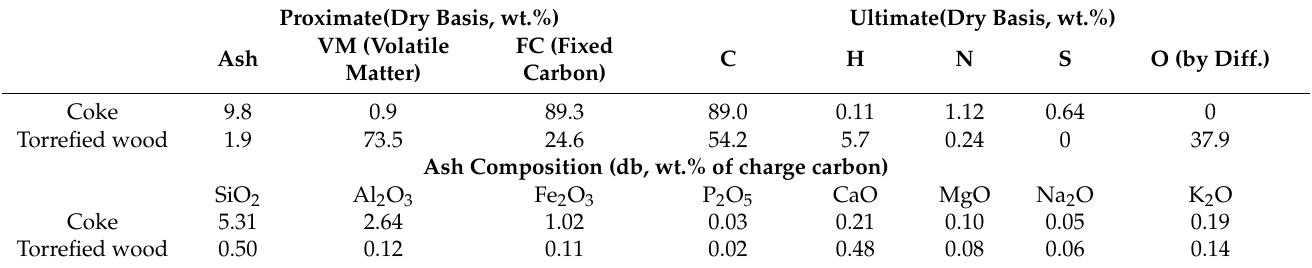
Table 3. Charge carbon